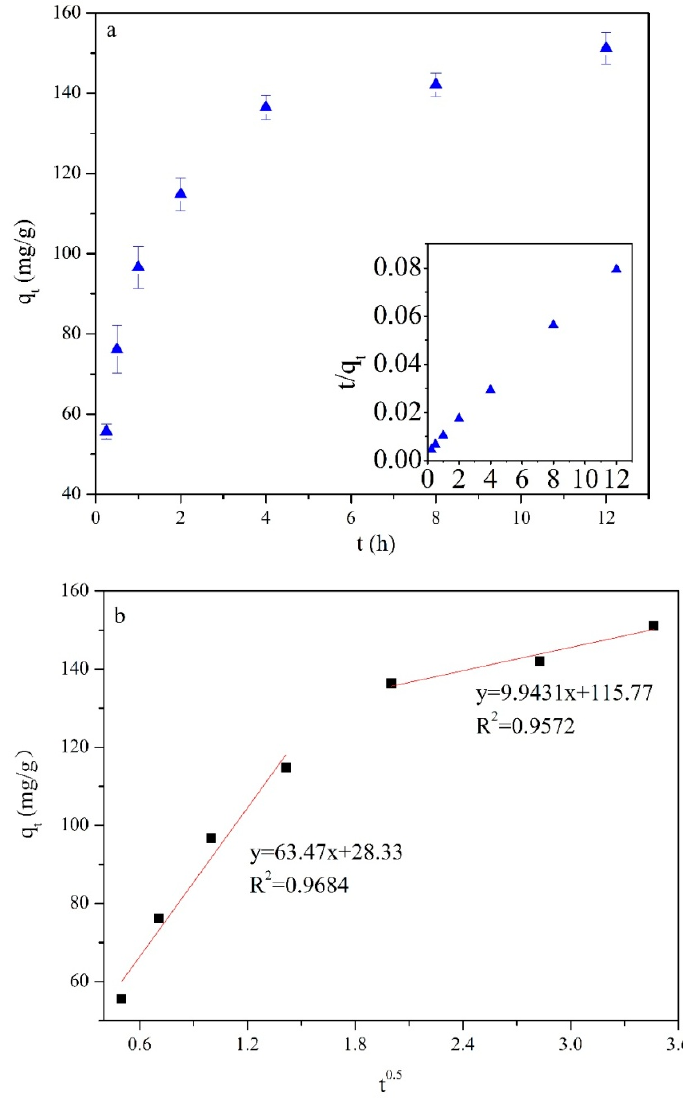
Figure 6. ( a ) Adsorption kinetics of ammonium on M-Zeo and the pseudo-second-order model; ( b ) the intraparticle diffusion model. ( b ) the intraparticle diffusion